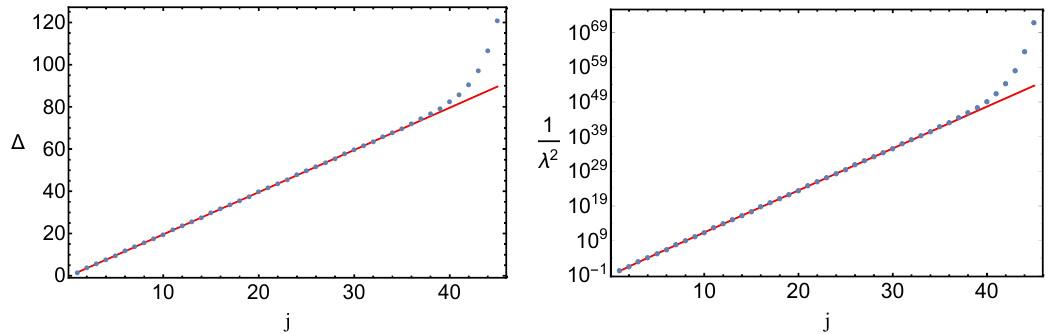
Figure 4 . Comparison between extrapolated vs exact spectra. The exact solution is the generalized free fermion with dimensions (cid:1)( j ) = 1+2(cid:1) (cid:30) +2 j (cf. (5.9)), here evaluated at (cid:1) (cid:30) = 0 : 3. The exact values lie on the solid red line whereas the extrapolated results are represented by the blue